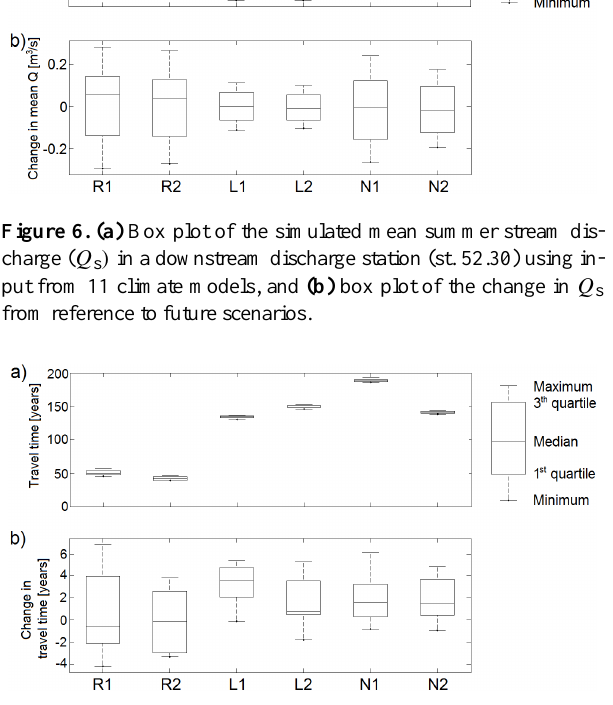
Figure 7. (a) Box plot of the simulated median travel time to Lavringe well field, and (b) box plot of the percentage change in median travel time from reference to future scenarios.